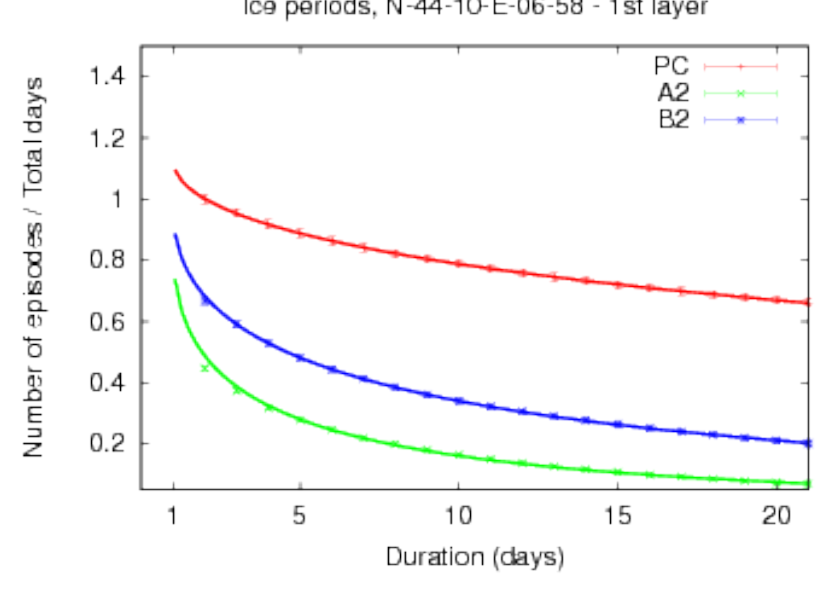
Figure 1. Frequency of cold spells versus their duration: the case expected by hypothesizing increasing average